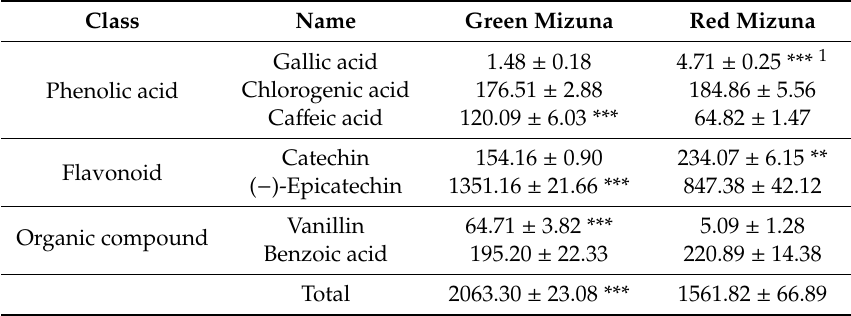
Table 3. Phenolic and organic compounds in green and red mizuna ( µ m / g dry